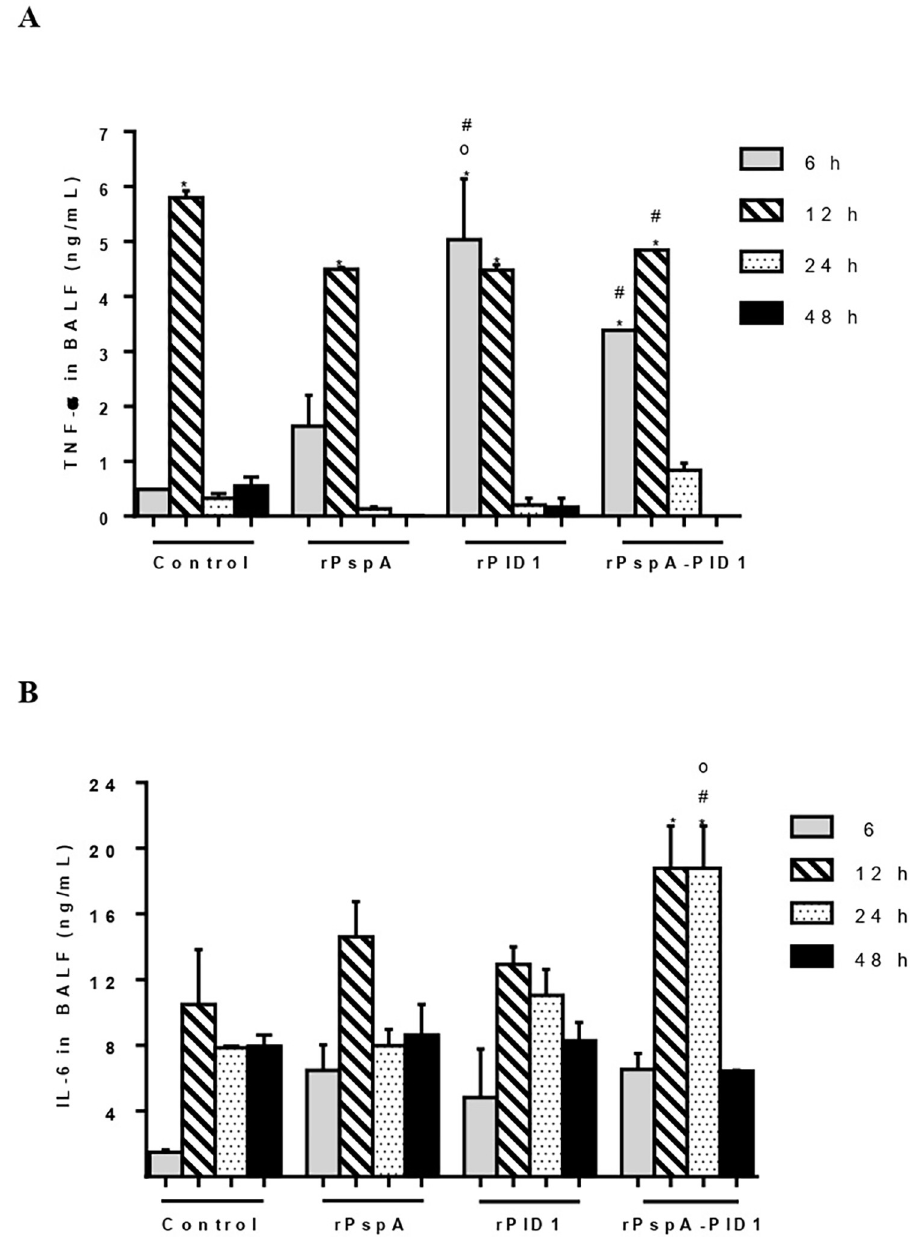
Fig 4. Cytokine production by immunized mice after pneumococcal challenge. Production of TNF- α (A) and IL-6 (B) in the BALF of immunized mice was detected by ELISA and compared with control mice (receiving adjuvant in PBS). � p < 0.05 for the same group at different time periods; #p < 0.05 as compared with the control group;˚p < 0.05 for the rPspA-PlD1 group as compared to the individual proteins.